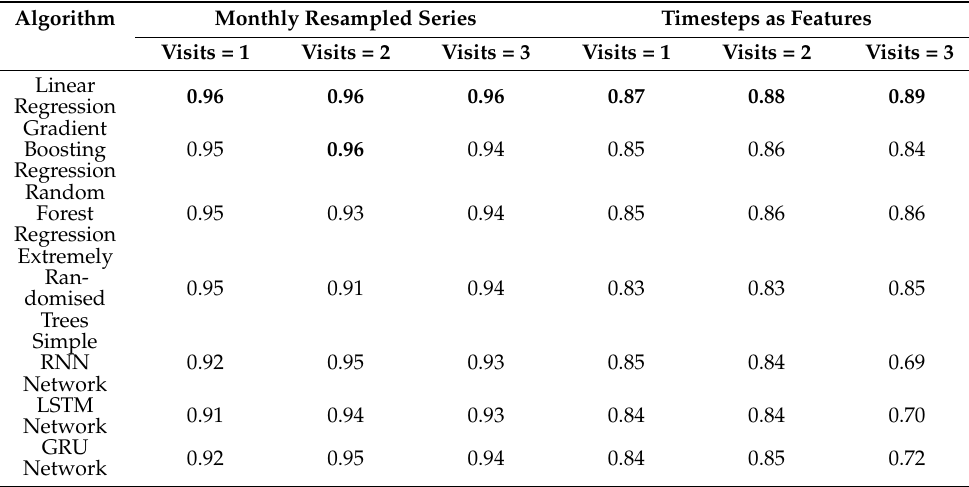
Table 6. R 2 results when forecasting from past visual acuity data (including information on when treatment was